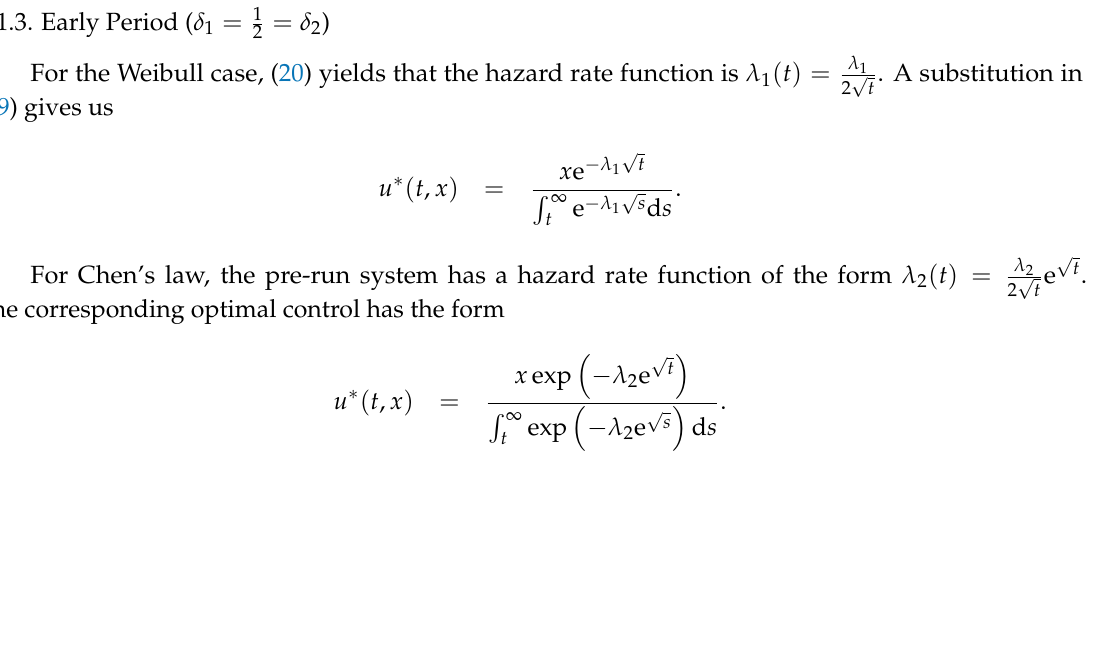
Figure 9. ease of the extraction for Weibull (red) and Chen (blue) laws when δ 1 = 2 = δ 2 and λ 1 = 1 = λ 2